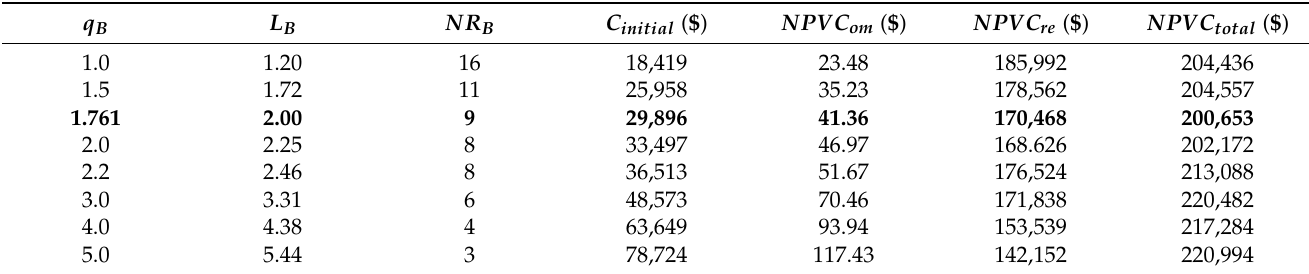
Figure 12. Net present value of the system total cost for different values of q B . Table 2. Simulation results for some of the q B